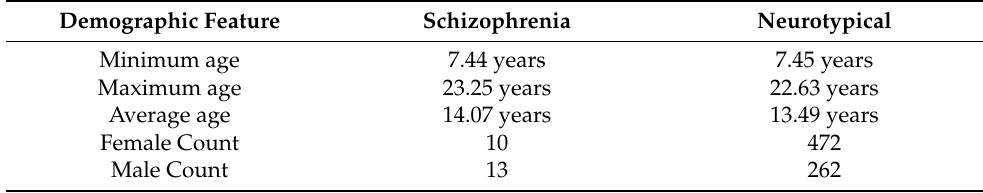
Table 1. Demographic Information of Study